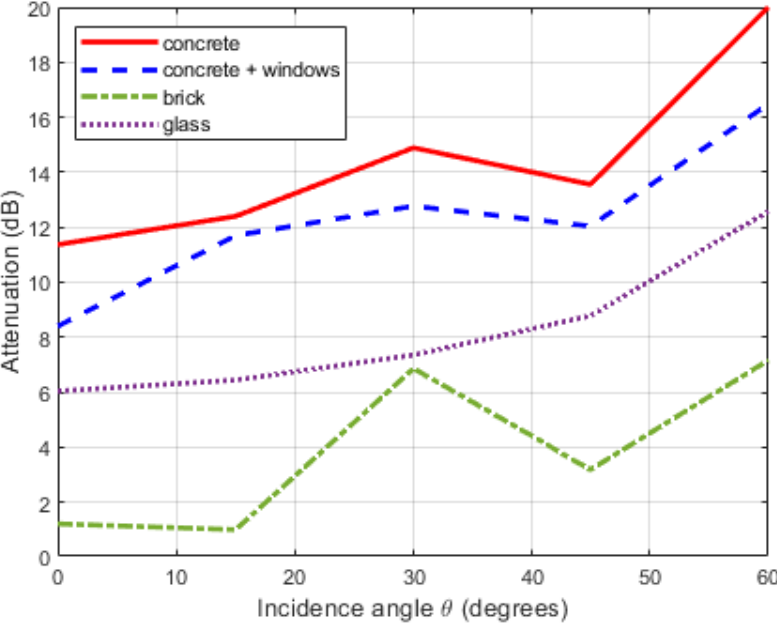
Figure 13. Attenuation as a function of incident angle θ for vertical polarization for 30 cm facades without windows (red solid line); and with windows (blue dashed line), 15 cm brick facade (green dash-dot line) and glass facade (purple dotted line).